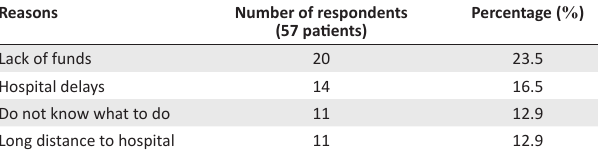
TABLE 4: Reasons for late presentation to hospital. Reasons